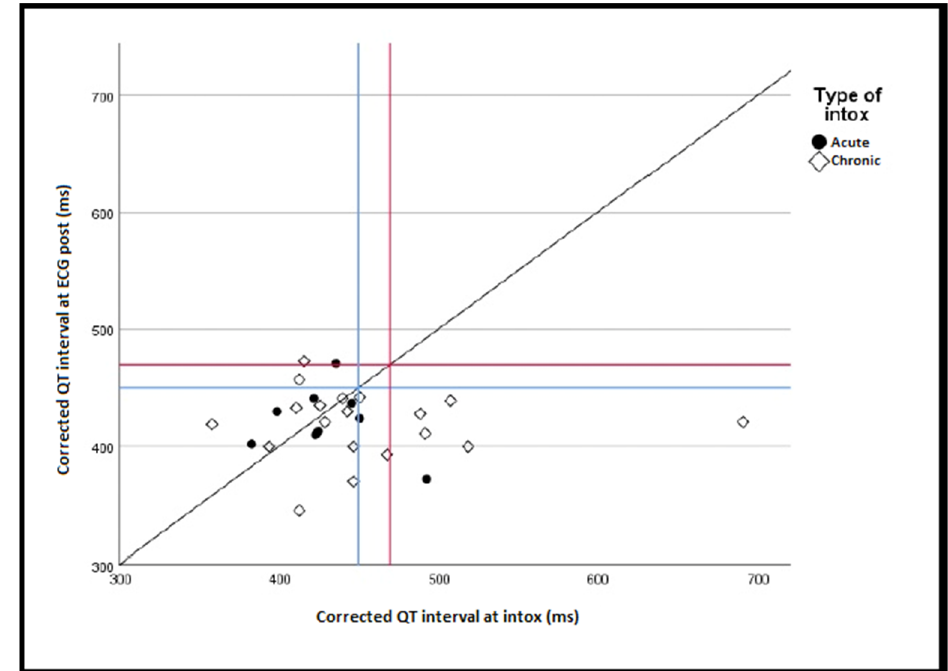
Figure 2. Relationship between QTc after and at the time of lithium intoxication ( n = 28). Blue lines at 450 ms indicating cut-off point for QT prolongation among men. Red lines at 470 ms indicating cut-off point for QT prolongation among women. Intox: intoxication; ms: millisecond. QTc on ECG INTOX correlated only weakly with s-Li at intoxication ( ρ = 0.329, p = 0.014)